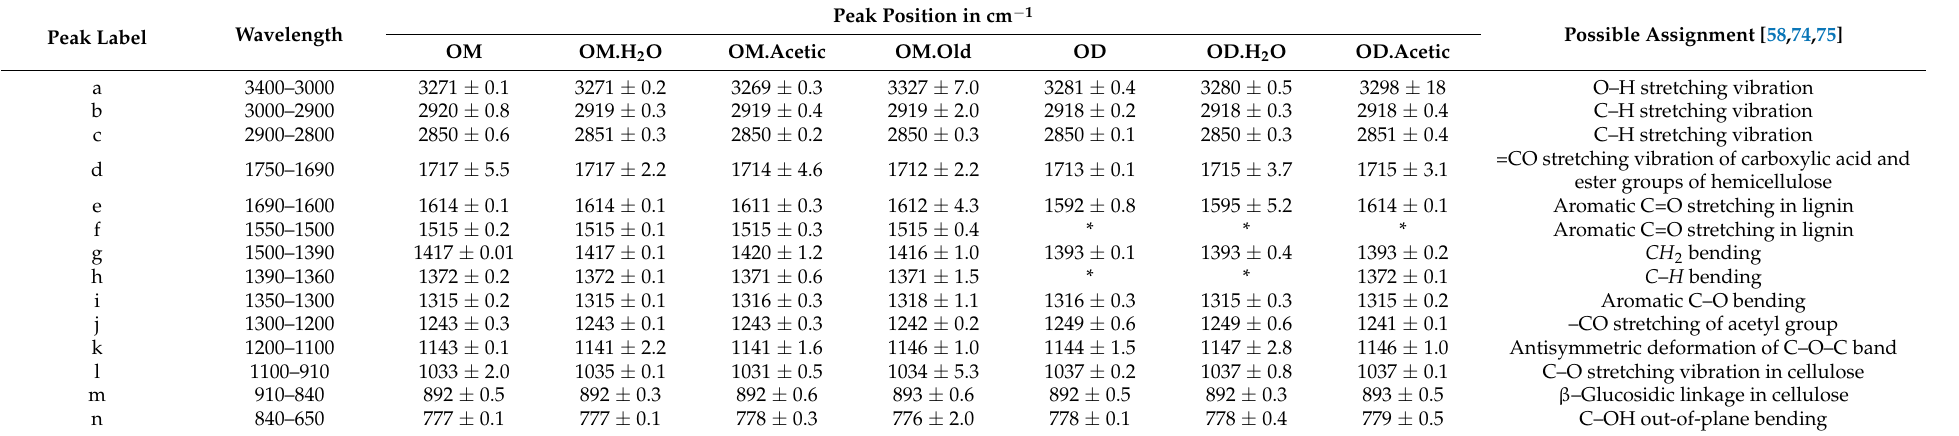
* Indicates the absence or decrease of the peak. Results show the mean value ± standard deviation of 3